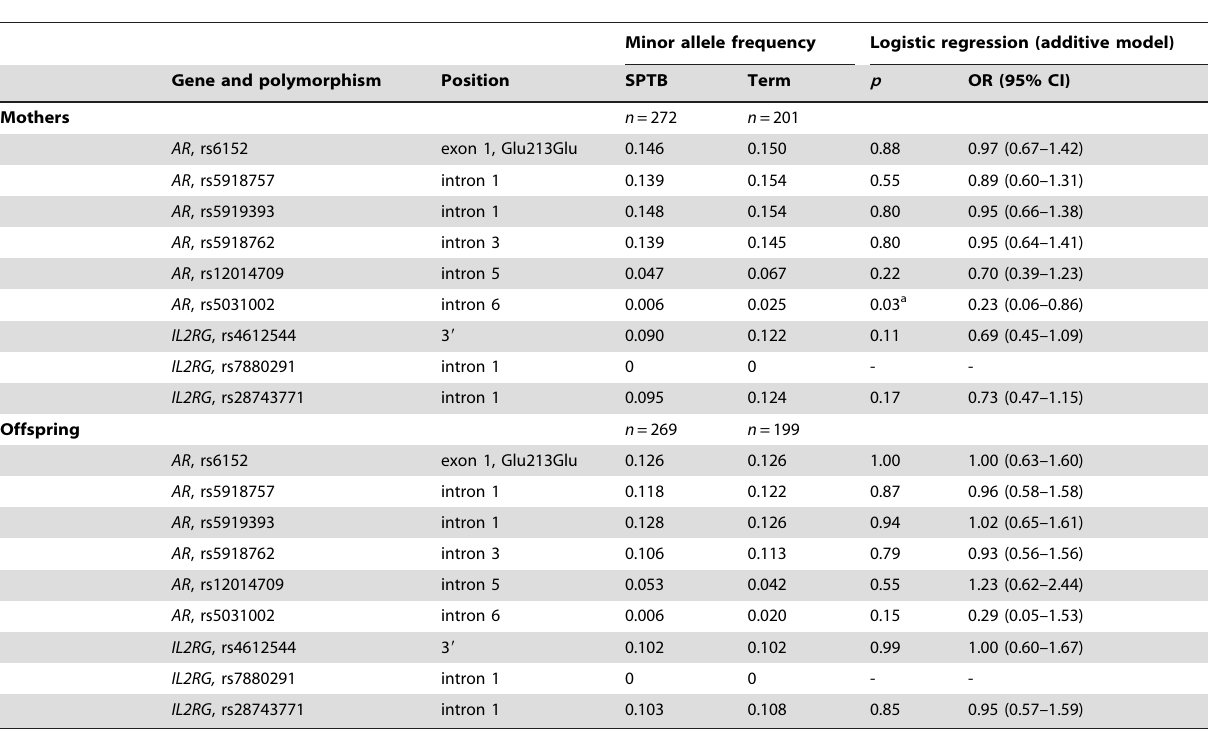
Table 3. Logistic regression analysis of AR and IL2RG polymorphisms in SPTB in the initial case-control population.